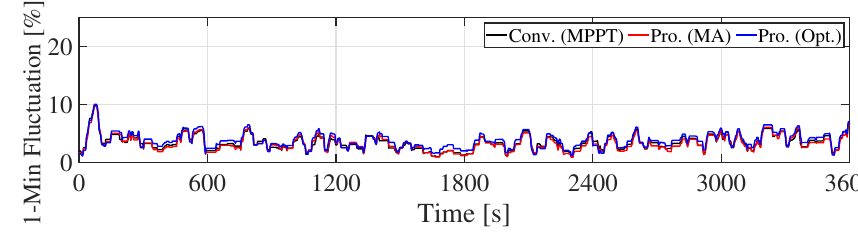
Figure 12. Fluctuation of WF output (Scenario 1).